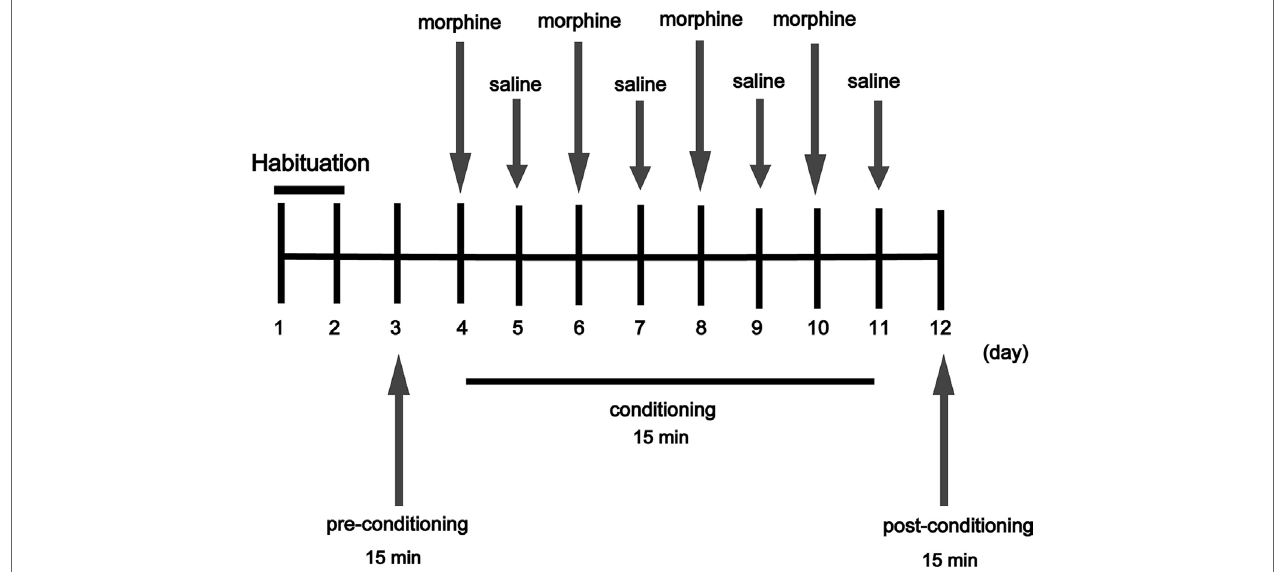
FigUre 1 | Experimental schedule for measurement of morphine-induced conditioned place preference in mice. Arrows indicate days on which behavioral tests were carried out (morphine 20 mg/kg).